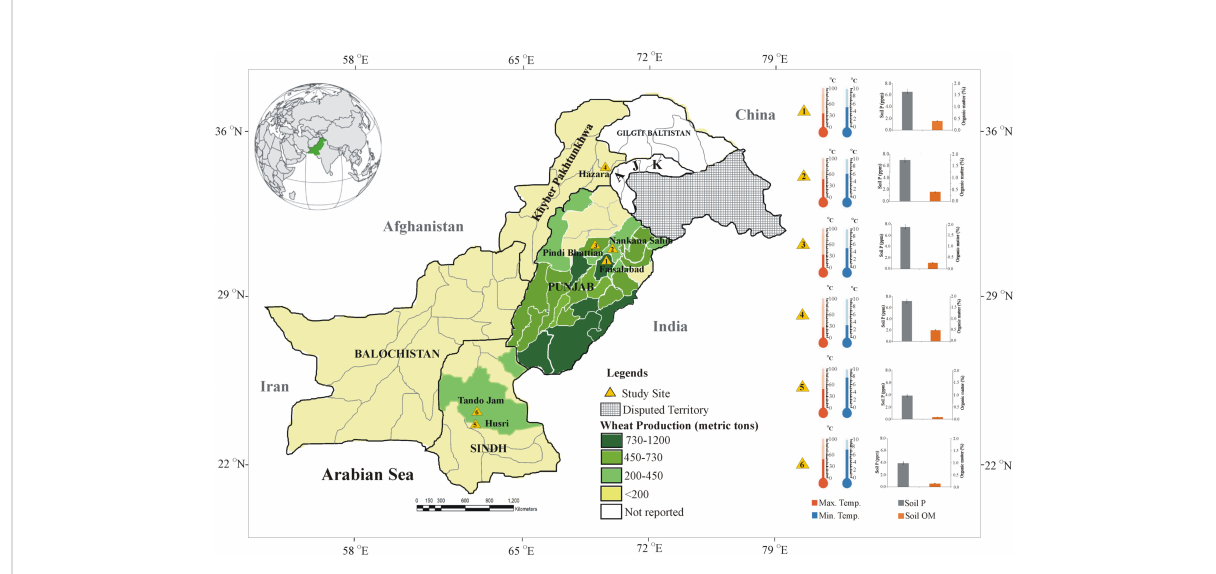
FIGURE 1 Map of Pakistan with multilocation trials targeted in the present study for evaluation of soil-speci fi c consortia on recommended wheat varieties. Different shades of green colors highlight the region showing wheat production in the main wheat districts of Pakistan (source: https://ipad.fas.usda. gov/countrysummary/Default.aspx?id=PK&crop=Wheat). Thermometers and bar graphs show climatic temperature (Pakistan Meteorological Department; source: https://www.pmd.gov.pk/en/) soil available P and organic matter of the soil of study